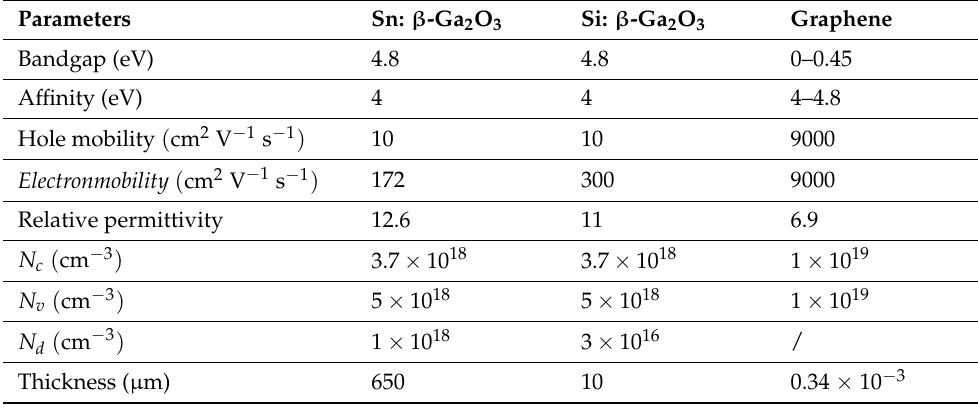
Table 1. Properties of each layer of the studied SBD [2,25]. Parameters